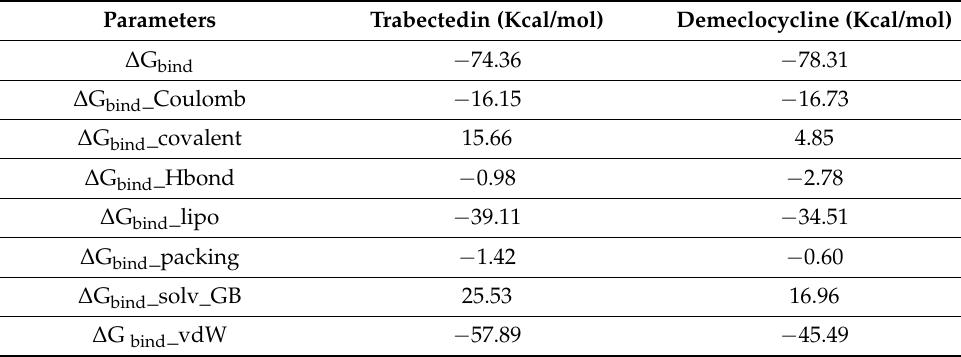
Table 3. Binding free energy values in kcal/mol of alpha Glucosidase complexed with Trabectedin and Demeclocycline calculated via MMGBSA method.